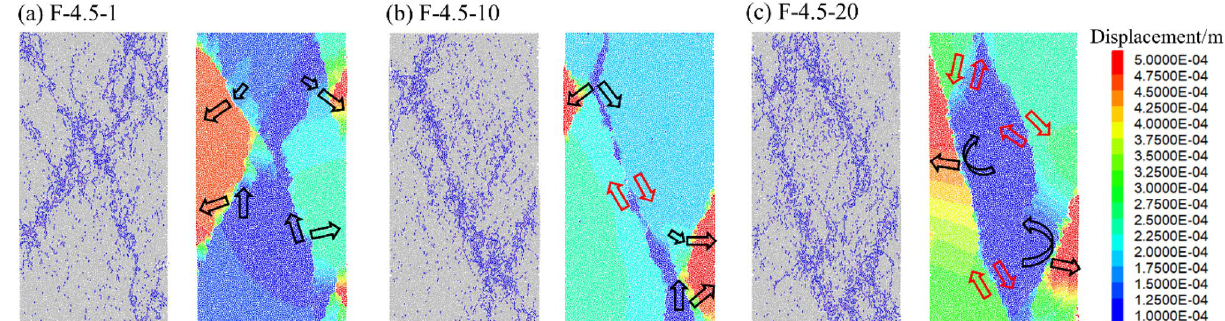
Figure 12. Crack distribution and displacement vector field of rock specimens ( A = 4.5